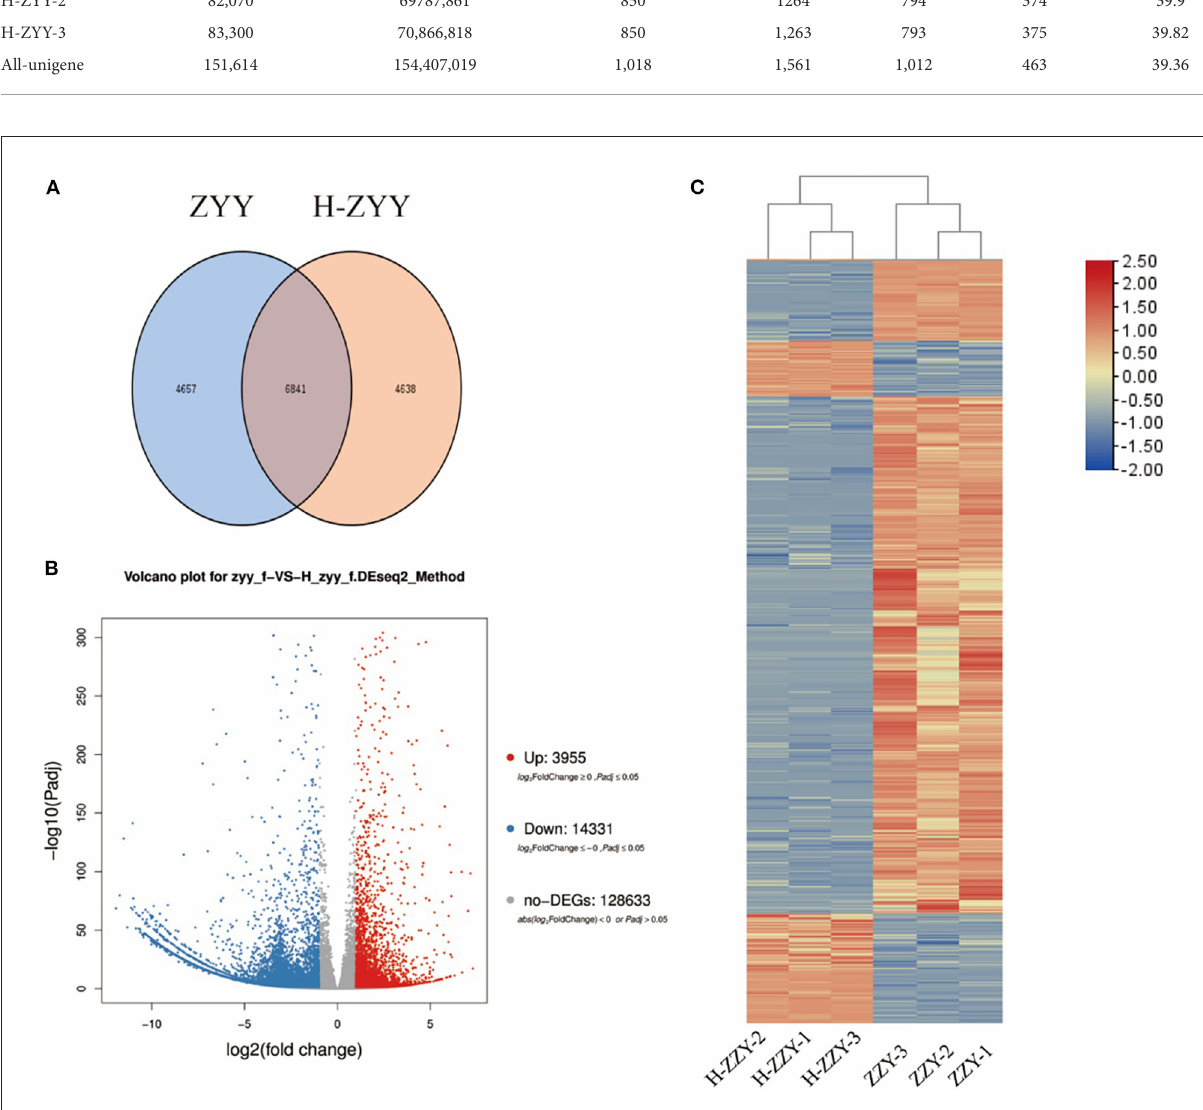
FIGURE4 Analysis of differentially expressed genes. (A) Venn diagram. (B) Volcano plot. (C) Heatmap.